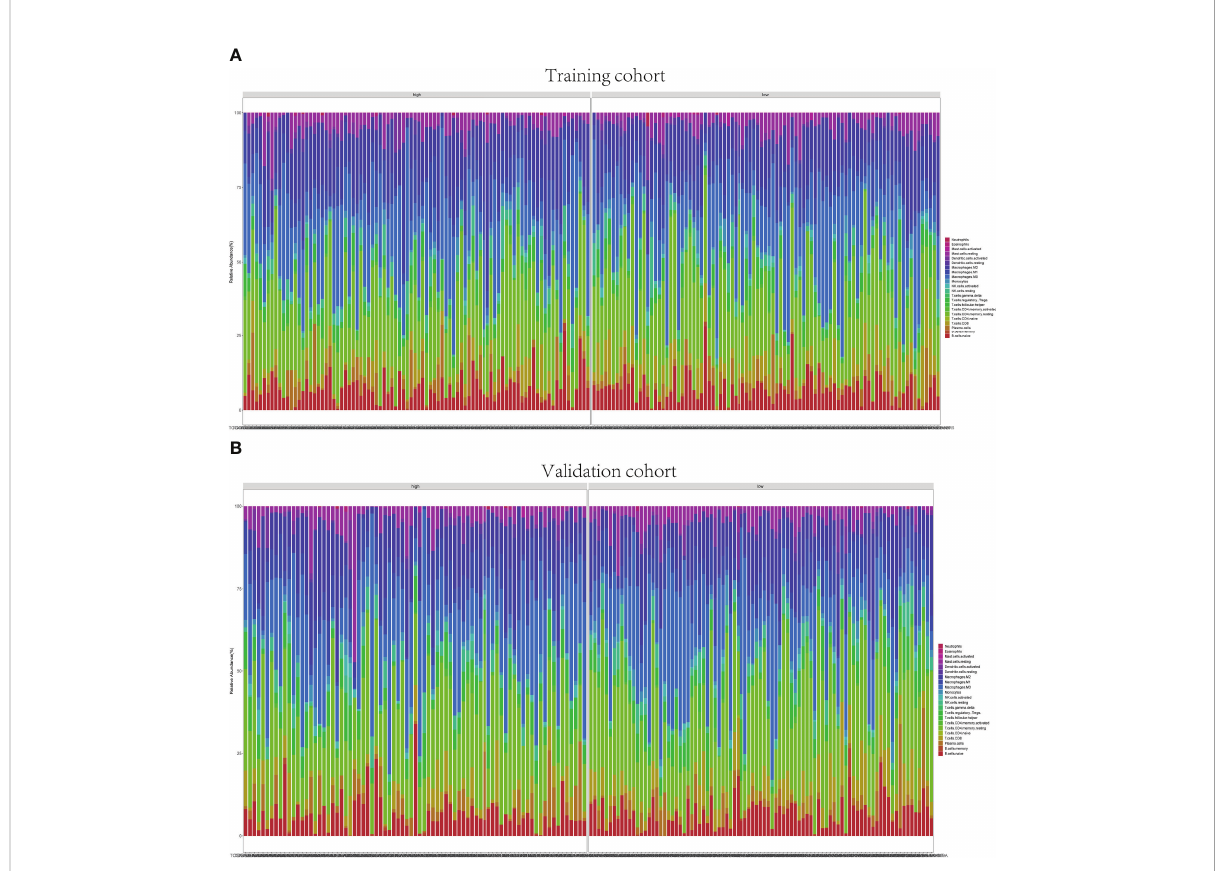
FIGURE 8 Immune in fi ltrations of training and validation groups. Relative proportion of immune in fi ltration in training group (A) and validation group (B)